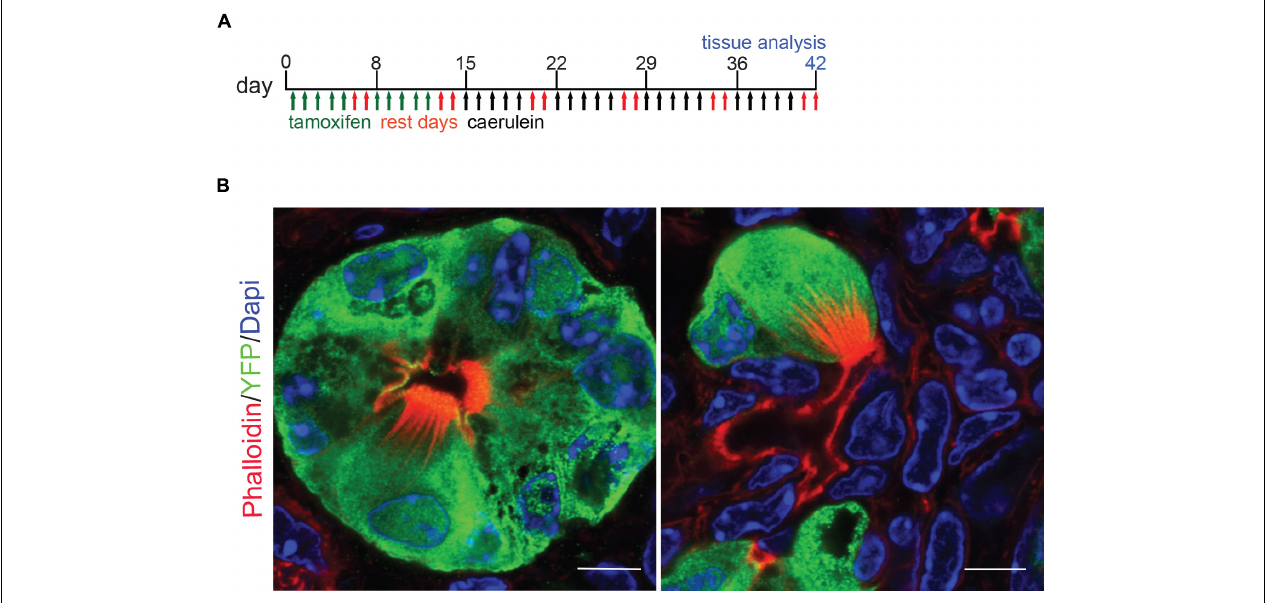
FIGURE 4 | Lineage tracing of pancreatitis tuft cells in wild type mice reveals acinar cell origin. (A) Schematic of tamoxifen and caerulein treatment for lineage tracing in Ptf1aCre ERTM / + ; Rosa YFP mice. (B) Co-immunofluorescence for tuft cell marker phalloidin (red, labels the microvilli and actin rootlets of tuft cells) and YFP, green, in caerulein-treated pancreata. Scale bar, 5 µ